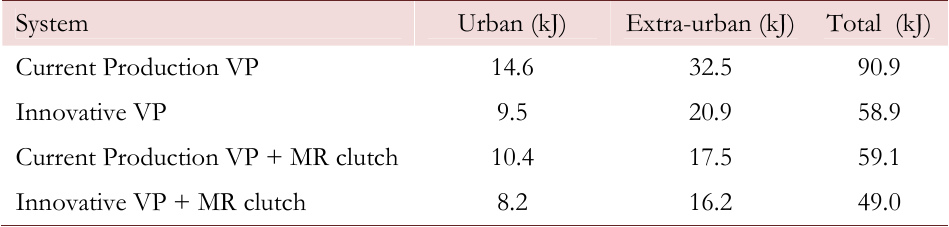
Table 3: Energy absorption during NEDC driving cycle